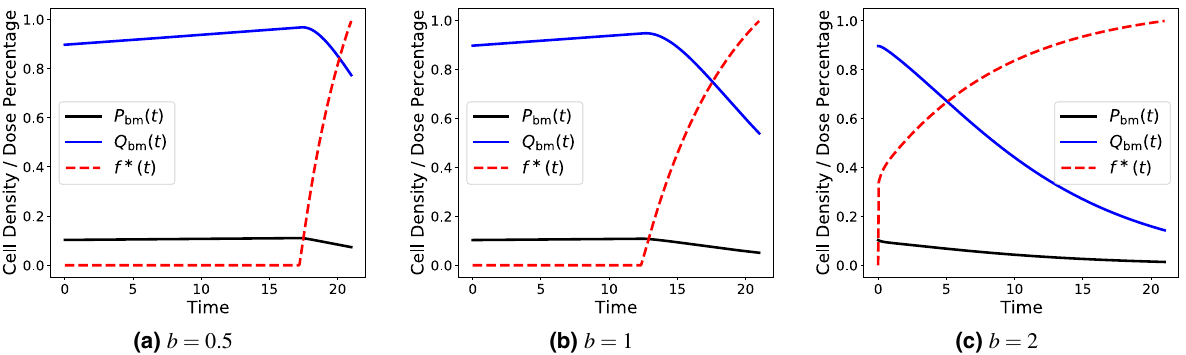
Figure 3. A plot of the proliferative cell proportion (black), the quiescent cell proportion (blue), and the optimal chemotherapeutic control f ∗ ( t ) (dashed red) for different values of b . The objective functional used to achieve this optimal control is given via Eq. (2). Small values of b correspond to weighting preservation of the bone marrow as more important and larger values of b correspond to weighting total drug delivery as more